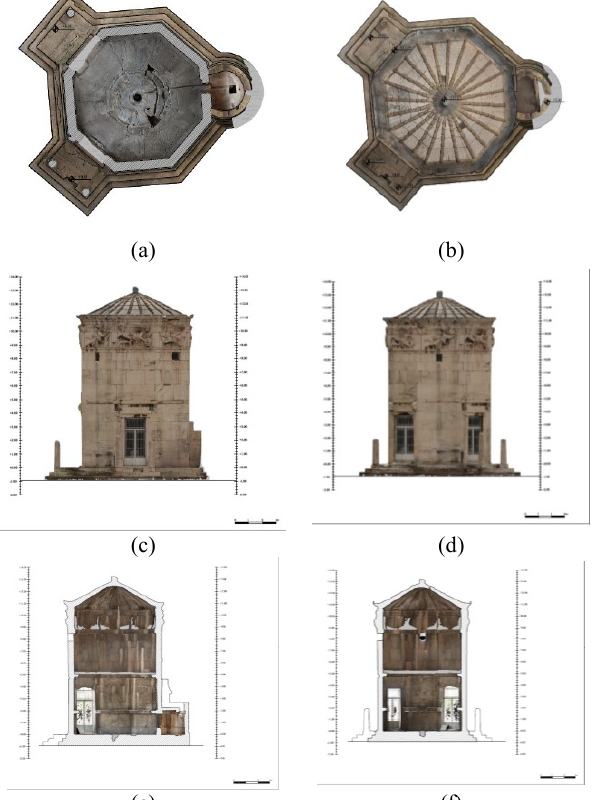
Figure 1: Samples of the final drawings. A horizontal section (a) and the bird’s eye view of the roof (b), tow outside elevations (c) and (d) and two vertical sections (e) and